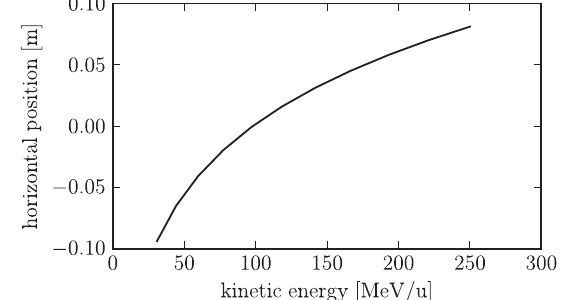
FIG. 6. Change in closed orbit position through acceleration, tracked using ZGOUBI .